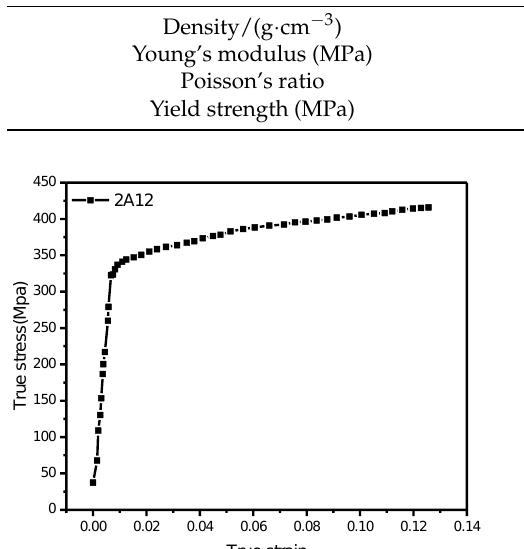
Table 1. Main material properties of the 2A12 aluminum alloy.